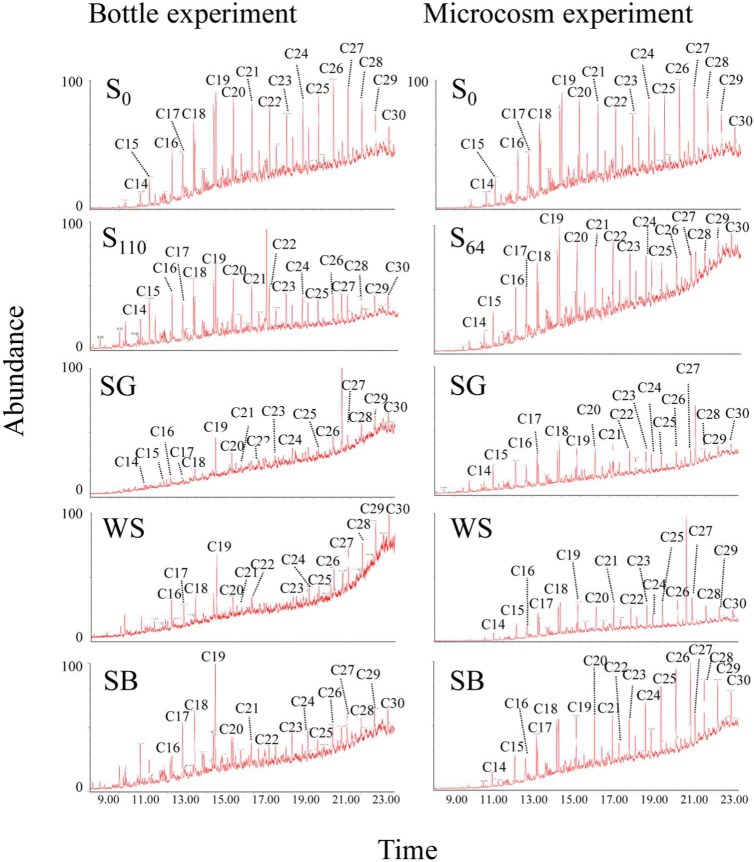
Gas chromatography/mass spectrometry (GC/MS) chromatograms showing the concentrations of crude oil fractions before and after biostimulation with sewage sludge (SG), wheat straw (WS), and soybean meal (SB) in the bottle and in the microcosm experiments. S0 denotes the original soil before incubation and S110 and S64 denote the same soil at the end of incubation without any treatment in the bottle and in the microcosm experiment, respectively.